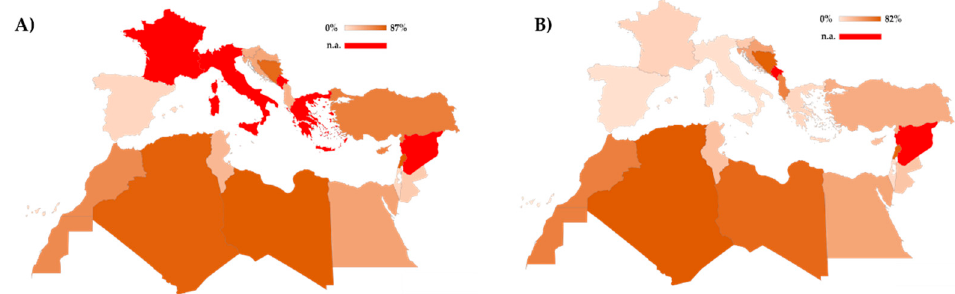
Figure 5. Percentage of domestic wastewater streams treated insecurely ( A ) and the percentage of the population that does not use safely managed sanitation facilities ( B ), 2017 [17].